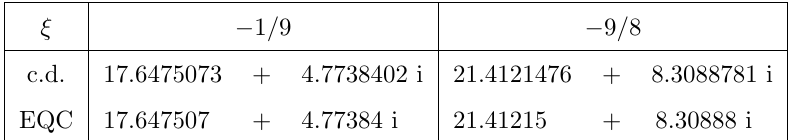
1 = 9 (left) and (cid:24) = 9 = 8 (cid:0) (cid:0)